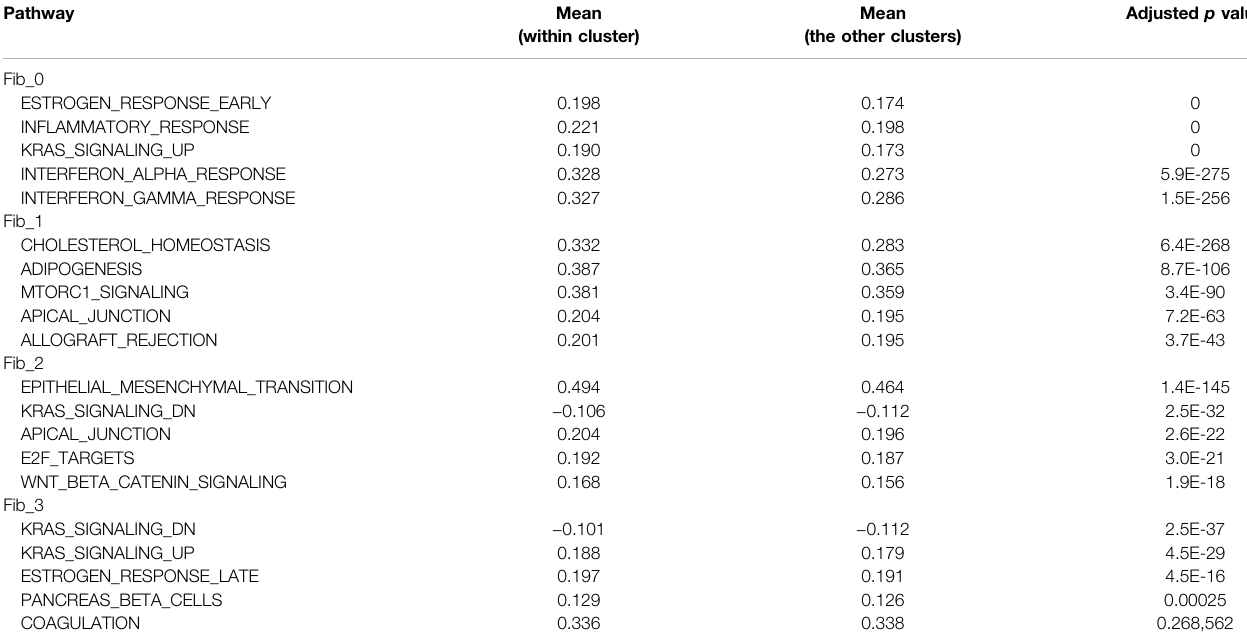
TABLE 1 | Top 5 signi fi cant gene signatures and mean ssGSEA scores for each fi broblast population. Pathway Mean